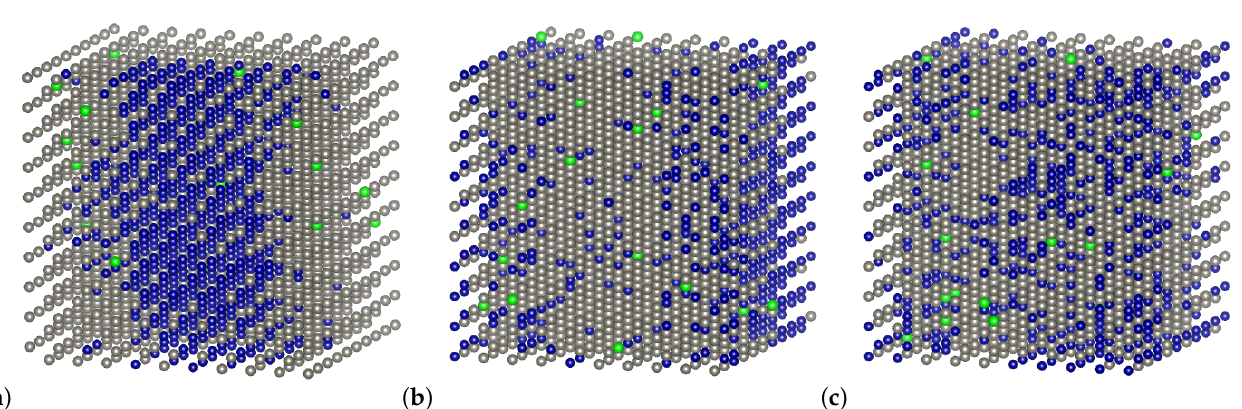
Figure 13. Structure images obtained from MC for W 70 Cr 29 Ti 1 alloy at ( a ) 1000 K, ( b ) 1400 K, and ( c ) 1800 K. W (grey), Cr (blue), Ti